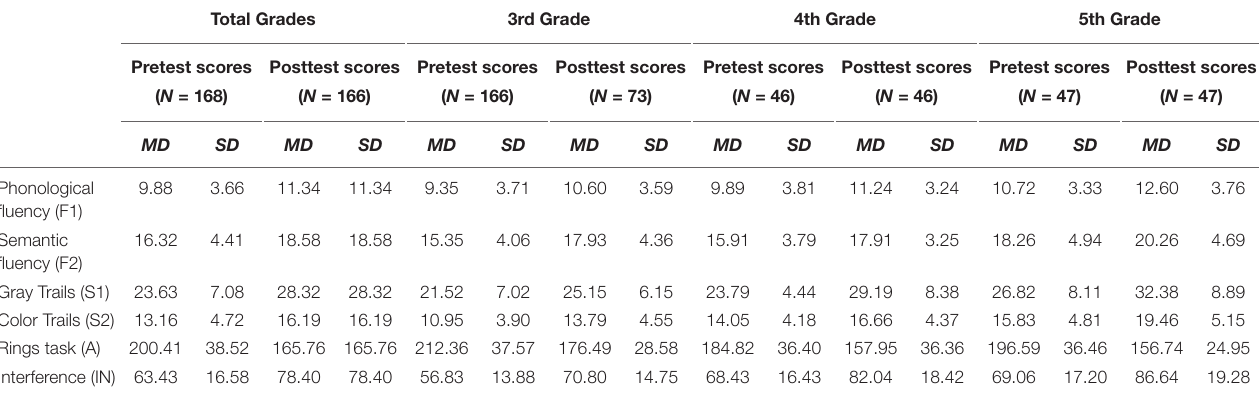
FIGURE 2 | Graphic of general descriptive statistics of the time of usage in Science, Logic, Spatial, and Arts. TABLE 1 | Descriptive statistics of children’s scores by groups from the ENFEN battery. Total Grades 3rd Grade 4th Grade 5th